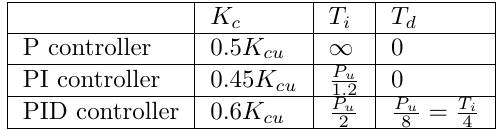
Table 2: Formulas for the controller parameters in the Ziegler-Nichols’ closed loop method.